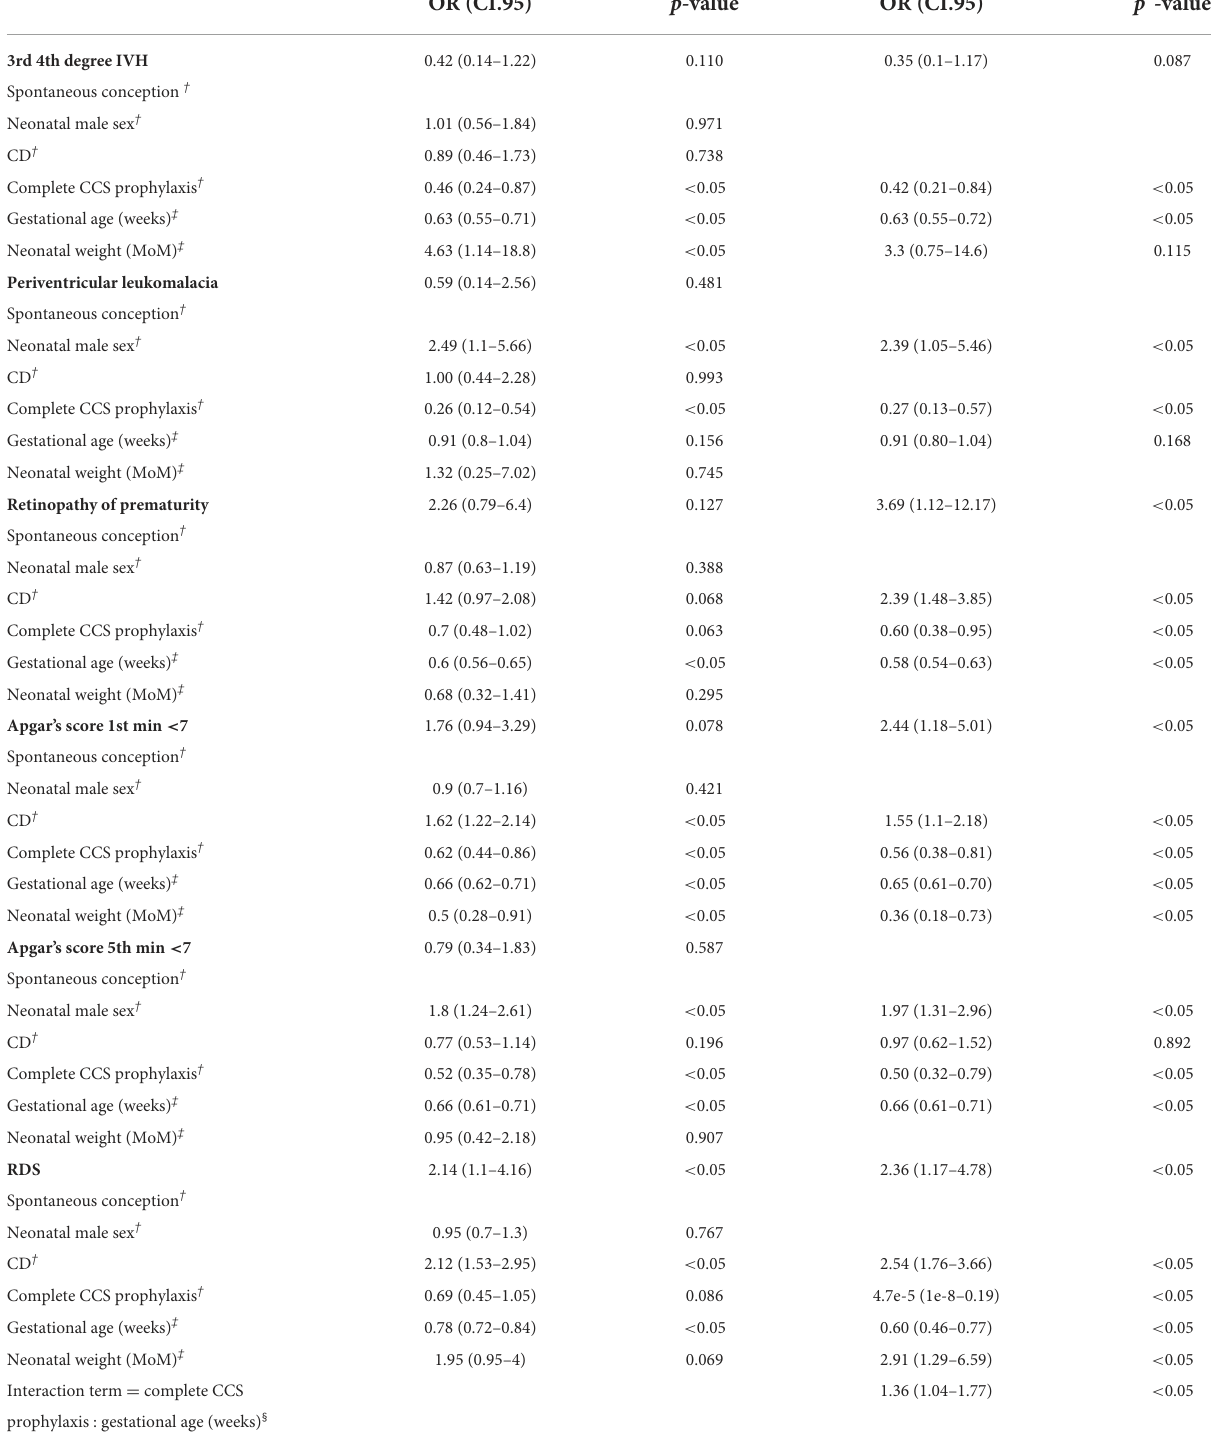
TABLE 3 Logistic regression analysis of the considered outcomes in the singleton pregnancies. OR